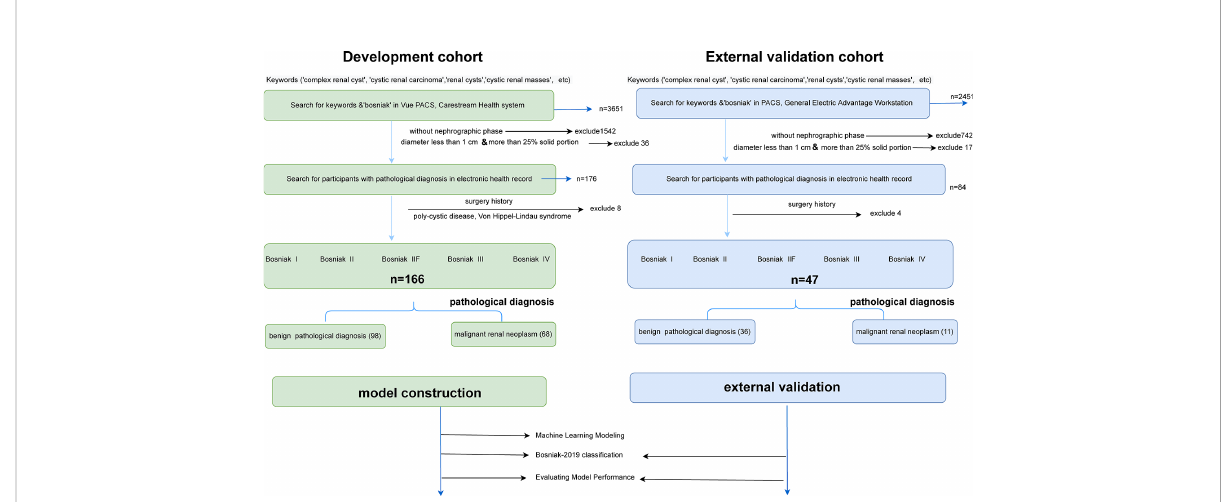
FIGURE 1 Flowchart illustrating how the cystic renal masses were enrolled and the distribution of pathology results in the fi nal datasets. Detailed inclusion and exclusion criteria are also displayed in the fl owchart. CRLs were classi fi ed as benign or malignant CRL based on pathological fi ndings. After that, training datasets were applied to build machine learning models, and testing datasets were adopted to reclassify cystic renal masses based on the Bosniak 2019 version and assess model